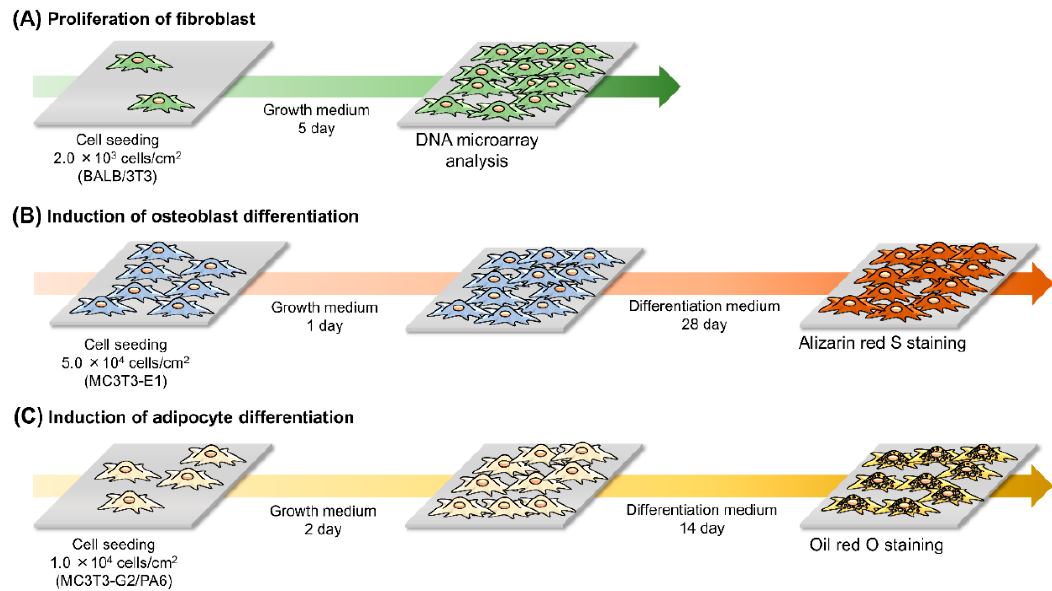
Figure 2. Experimental design for ( A ) fibroblast proliferation, ( B ) induction of osteoblast differentiation, and ( C ) induction of adipocyte differentiation.